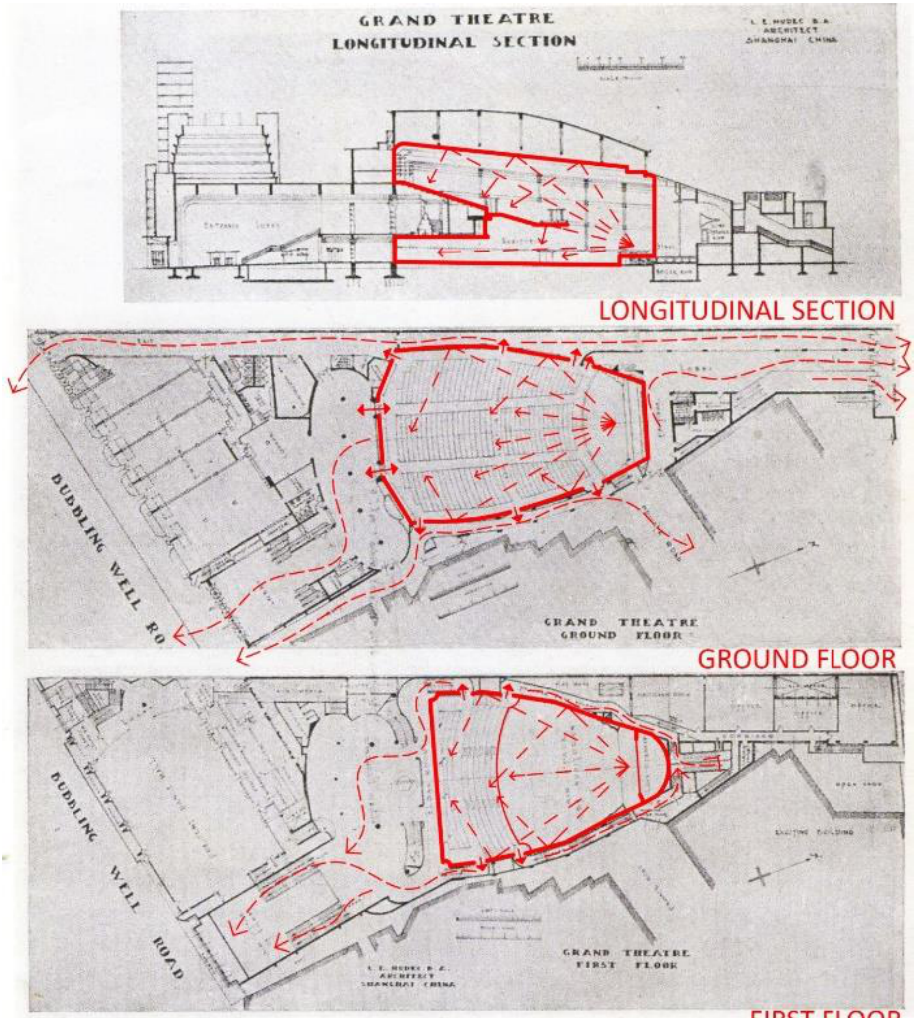
Figure 20. Grand Theatre—longitudinal section and plans; shape, acoustics, visibility and evacuation of the auditorium.